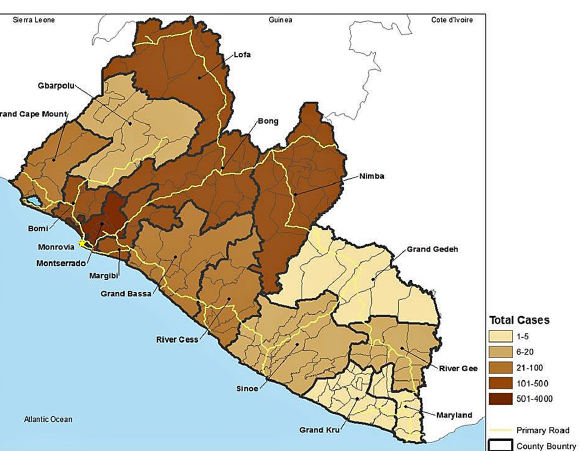
Fig 3. Geographical distribution of Ebola virus disease cases in Liberia, by county. Data are estimates made on 10 May 2015 [3]. Liberia had the second highest level of cumulative confirmed, probable, and suspected cases in West Africa as of this date, with the greatest mortality.